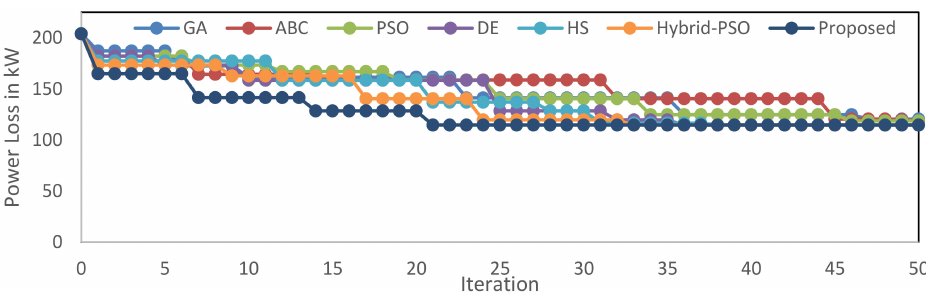
Figure 7. Bus voltage of test case 1 under single fault condition (SFC) at zone 5.